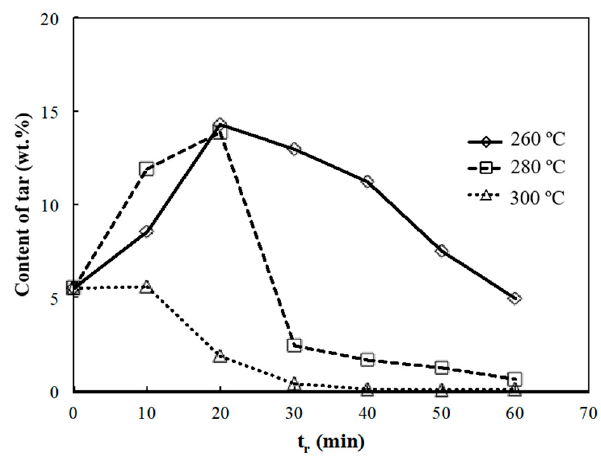
Figure 6. Dry-based tar or oil content of JME T in various torrefaction conditions.